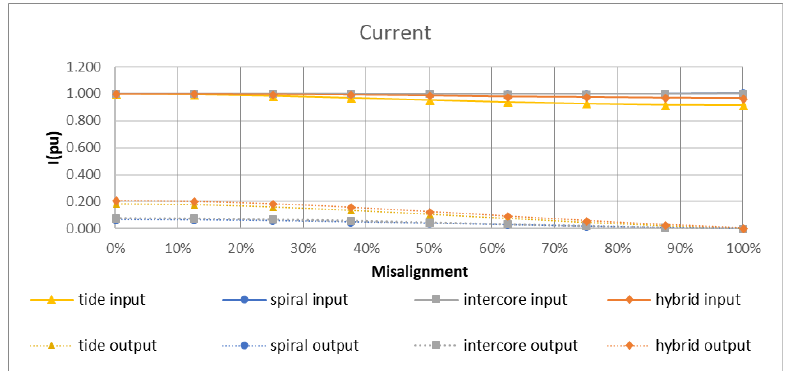
Figure 11. Simulation